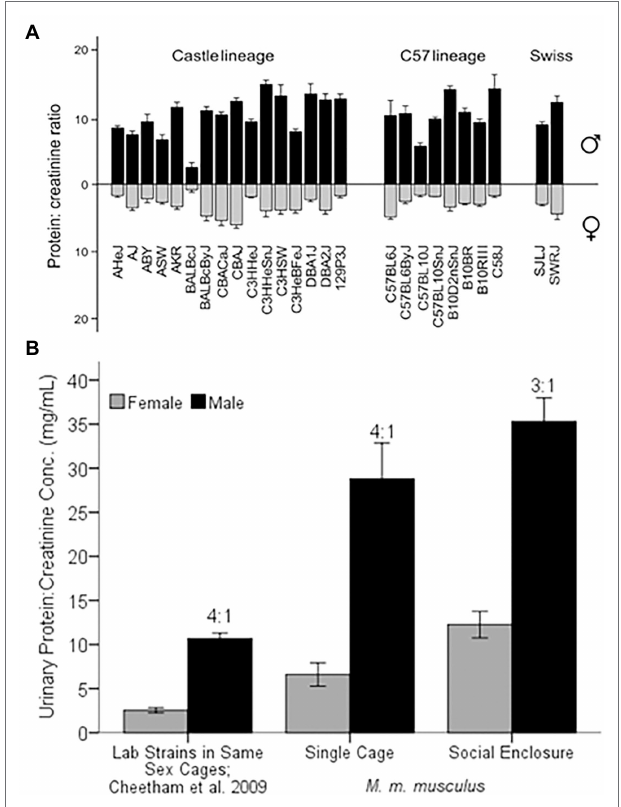
FIGURE 3 | Sex Differences in Urinary Protein Excretion. (A) Comparison of 26 strains of laboratory mice (protein:creatinine concentration in mg/ml) for males and females, represented as black and gray bars, respectively . Figure used with permission from Cheetham et al. (2009). (B) MUP excretion of laboratory versus wild-derived house mice. Laboratory strains were housed in same-sex cages of 5 individuals of the same strain (Cheetham et al., 2009). Wild-derived M. musculus musculus were either singly housed (Single Cage) or living in seminatural conditions (Social Enclosure) at 1:1 sex ratio (modified from Luzynski et al., 2021). The ratio above the black bars is the male:female ratio of protein excretion. Error bars indicate ±1